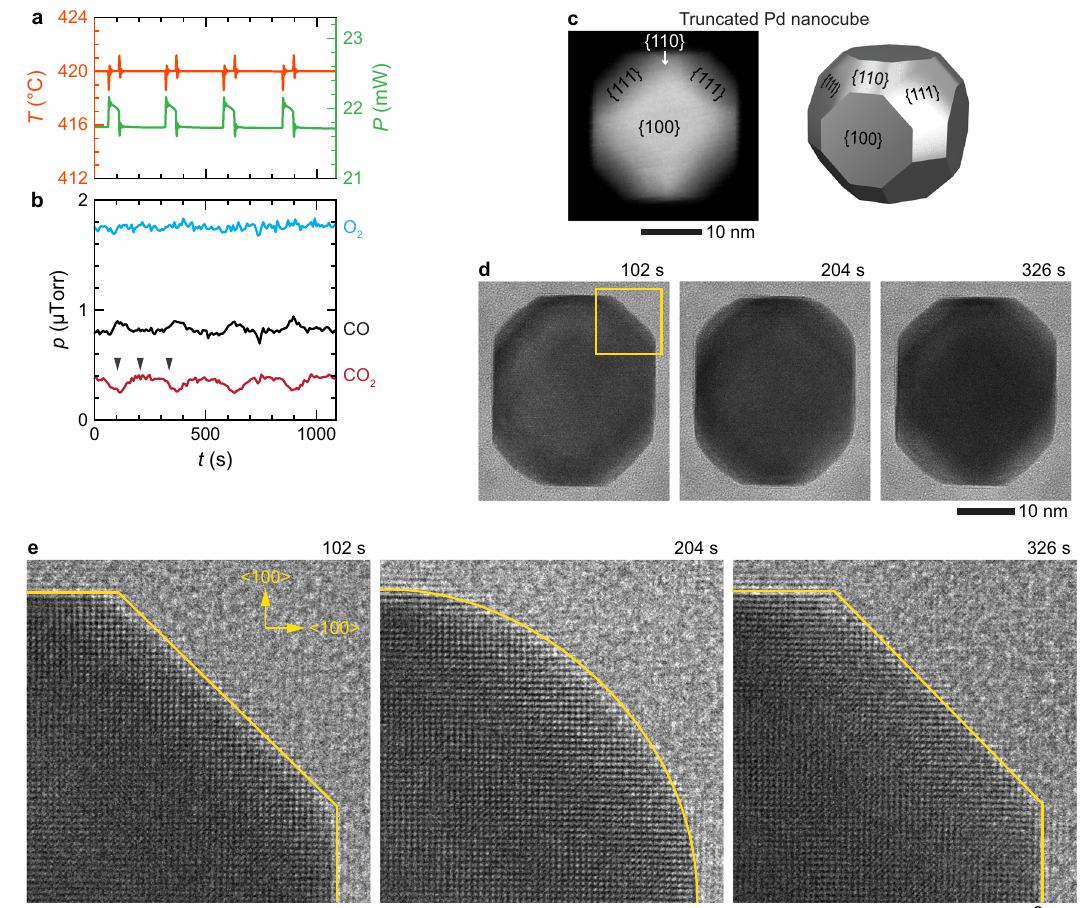
Fig. 3 | Restructuring of a truncated Pd nanocube during an oscillatory CO high-activitystatesduringtheoscillation. e High-resolutionimageseriesoftheNP ’ s oxidationreaction. a Plotsofthe measuredtemperature, heater power,and b the corner, as indicated by the yellow box in d . During the reaction, the corners of the truncated nanocube restructure between the round (at 204s) and fl at (at 102 and corresponding amounts of the CO, O 2 , and CO 2 gases during the oscillatory CO ≈ 0 : 5. The arrows in b correspond to the 326s) facets (Supplementary Movie 2; see Supplementary Fig. 10 for the details of oxidation reaction at 420°C and p CO = p O 2 the rest of oscillation during 500s< t timepoints of the image seriesshown in d , e . c STEMimageand the schematicofa truncatednanocube. d InsituTEMimageseriesofatruncatednanocubeinlow-and